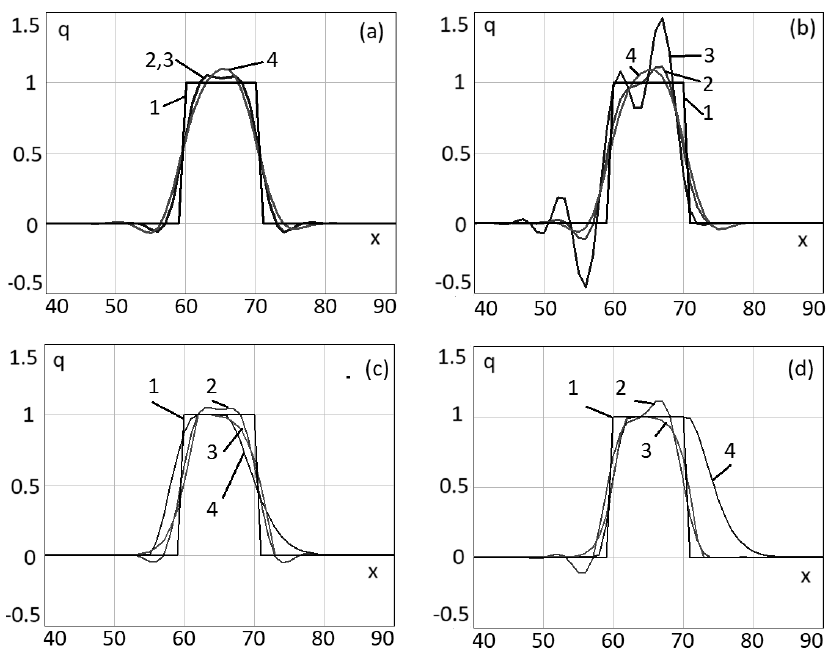
Figure 4. Solutions of the test problem I for time interval T = 100 s and different time steps: ( a , c ) τ = 0.02 s; ( b , d ) τ = 0.4 s; ( a , b ): 1—exact solution, 2— numerical solution based on the scheme (14), 3— numerical solution based on the scheme (18), 4— numerical solution based on the scheme (19); ( c , d ): 1—exact solution, 2—numerical solution based on the scheme (14), 3—numerical solution based on the Upwind Leapfrog scheme with TVD-limiters [27], 4—numerical solution based on the Standard Leapfrog scheme with